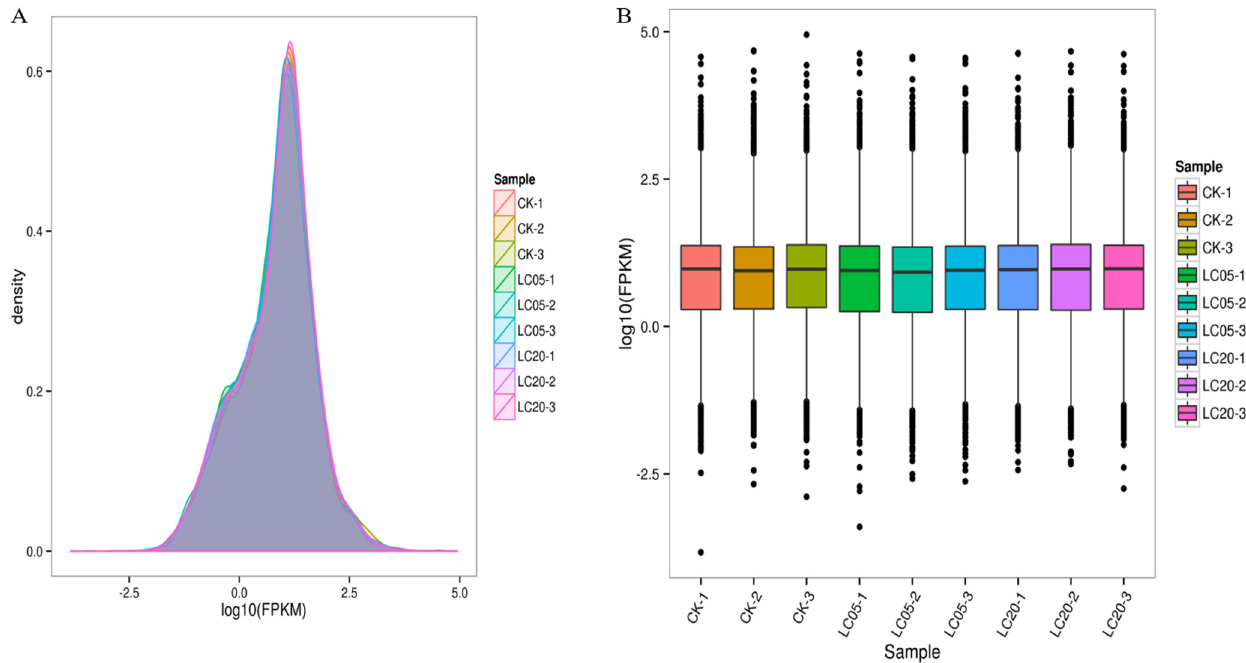
Figure 2. Bioinformatic analyses of RNA-seq data. ( A ) Density distribution of FPKM for each group; ( B ) FPKM density distribution boxplot for each group.